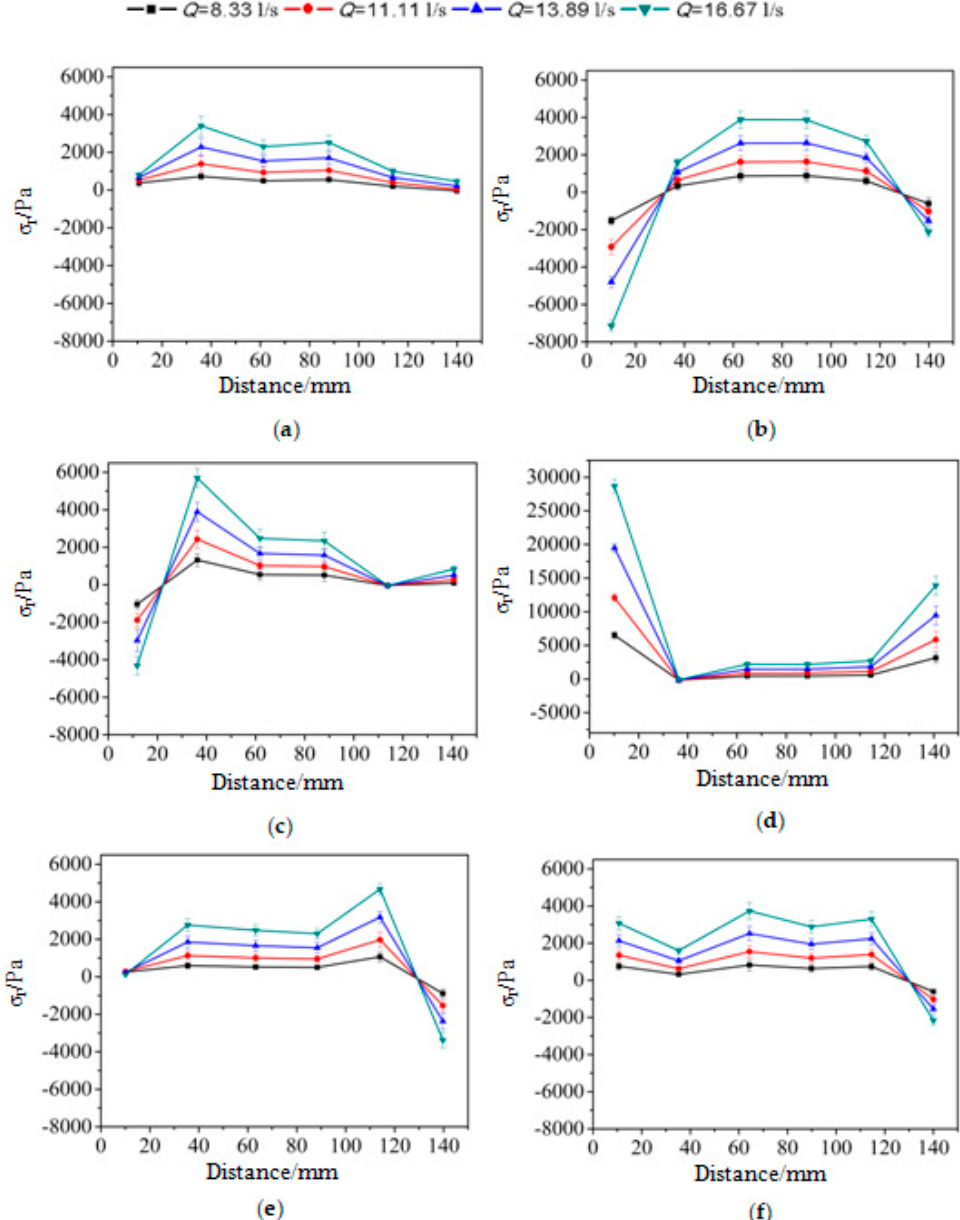
Figure 11. Radial principal-stress component on capsule surface. ( a ) θ = 0°; ( b ) θ = 30°; ( c ) θ = 60°; ( d ) θ = 90°; ( e ) θ = 120°; ( f ) θ = 150°.